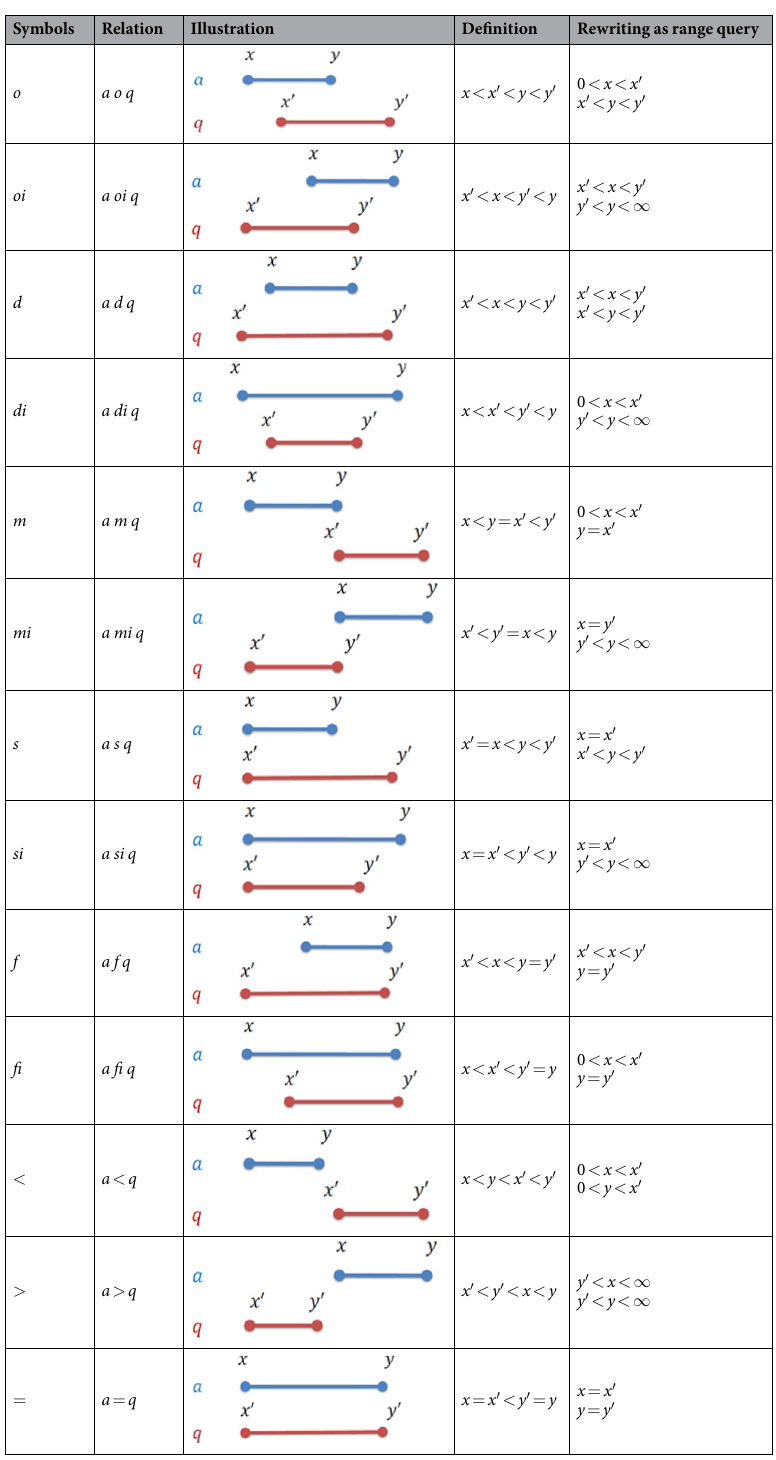
Table 1. Allen’s interval relations and their transformation to the bound range for range query. Note: a = [ x , y ] is an interval from the data interval set, q = [ x ′ , y ′ ] is the query